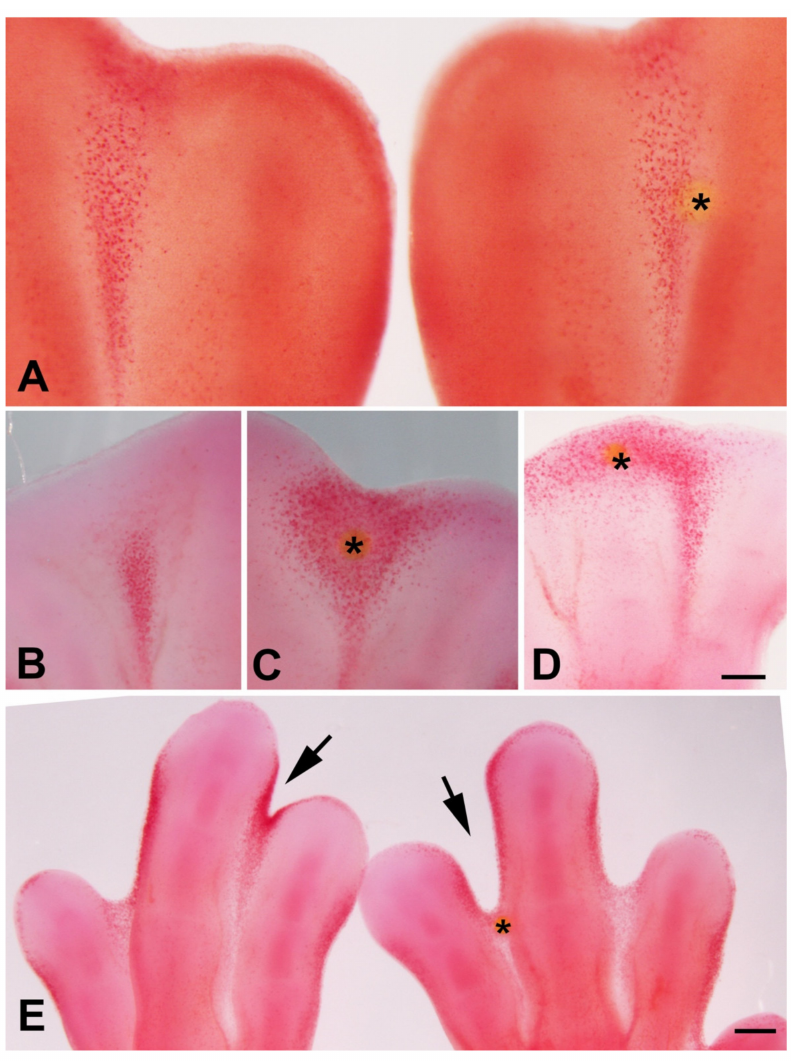
Figure 4. TSA induces cell death and DNA damage. ( A ) Interdigital spaces neutral red vital stained 36 h after the implantation of a PBS bead (*) in the right limb. Note that the pattern of interdigital cell death has not been changed in the interdigits subjected to implantation of a control bead. ( C , D ) Control ( left ) ( C ) and experimental (right) interdigits ( D ) vital stained with neutral red to illustrate the intense induction of cell death 24 h after implantation of a TSA bead (*). ( D ) Experimental autopod showing the pattern of cell death induced by implantation of a TSA bead at the tip of the growing digit III. Note that death extends through the undifferentiated mesoderm while it is absent at the cartilaginous end of the digit close to the bead (*). ( E ) Control (left) and experimental (right) autopod vital stained with neutral red 48 h after implantation of a TSA bead (*). Note the advanced stage on interdigital remodeling in the treat interdigits in comparison with its control right autopod (arrows). Magnification bar in ( A – C ) = 200 µ m; bar in ( D ) = 300 µ